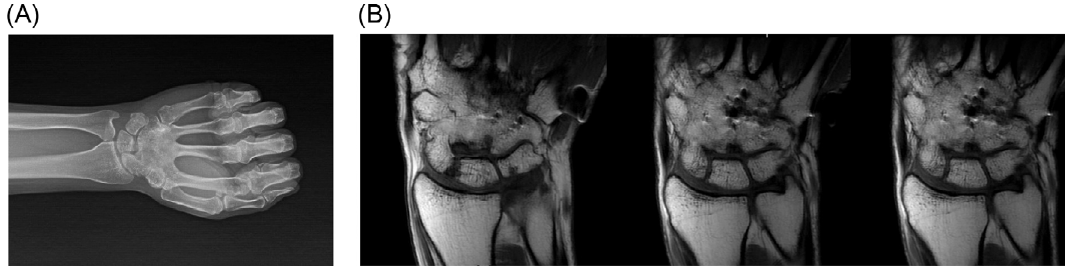
Figure 5. (A) Roentgenogram of the operated wrist at 10-year follow-up, (B) MRI of the operated wrist at 10-year